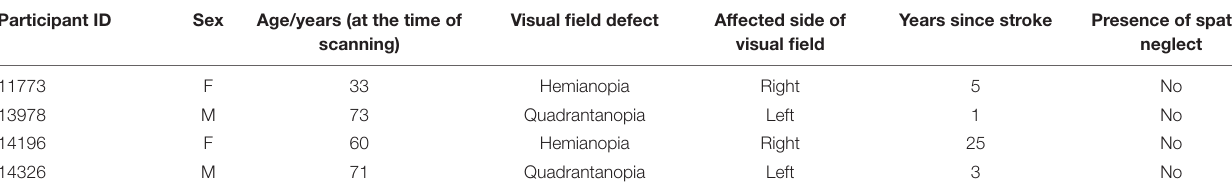
TABLE 1 | Demographic and basic clinical information about